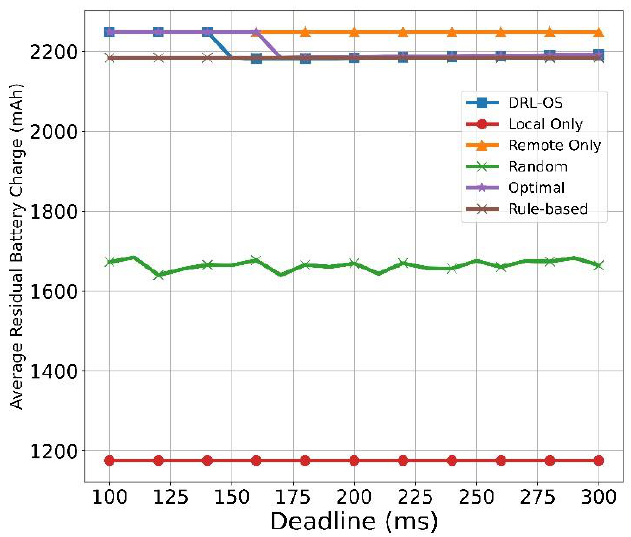
Figure 13. Average residual battery vs. deadline.